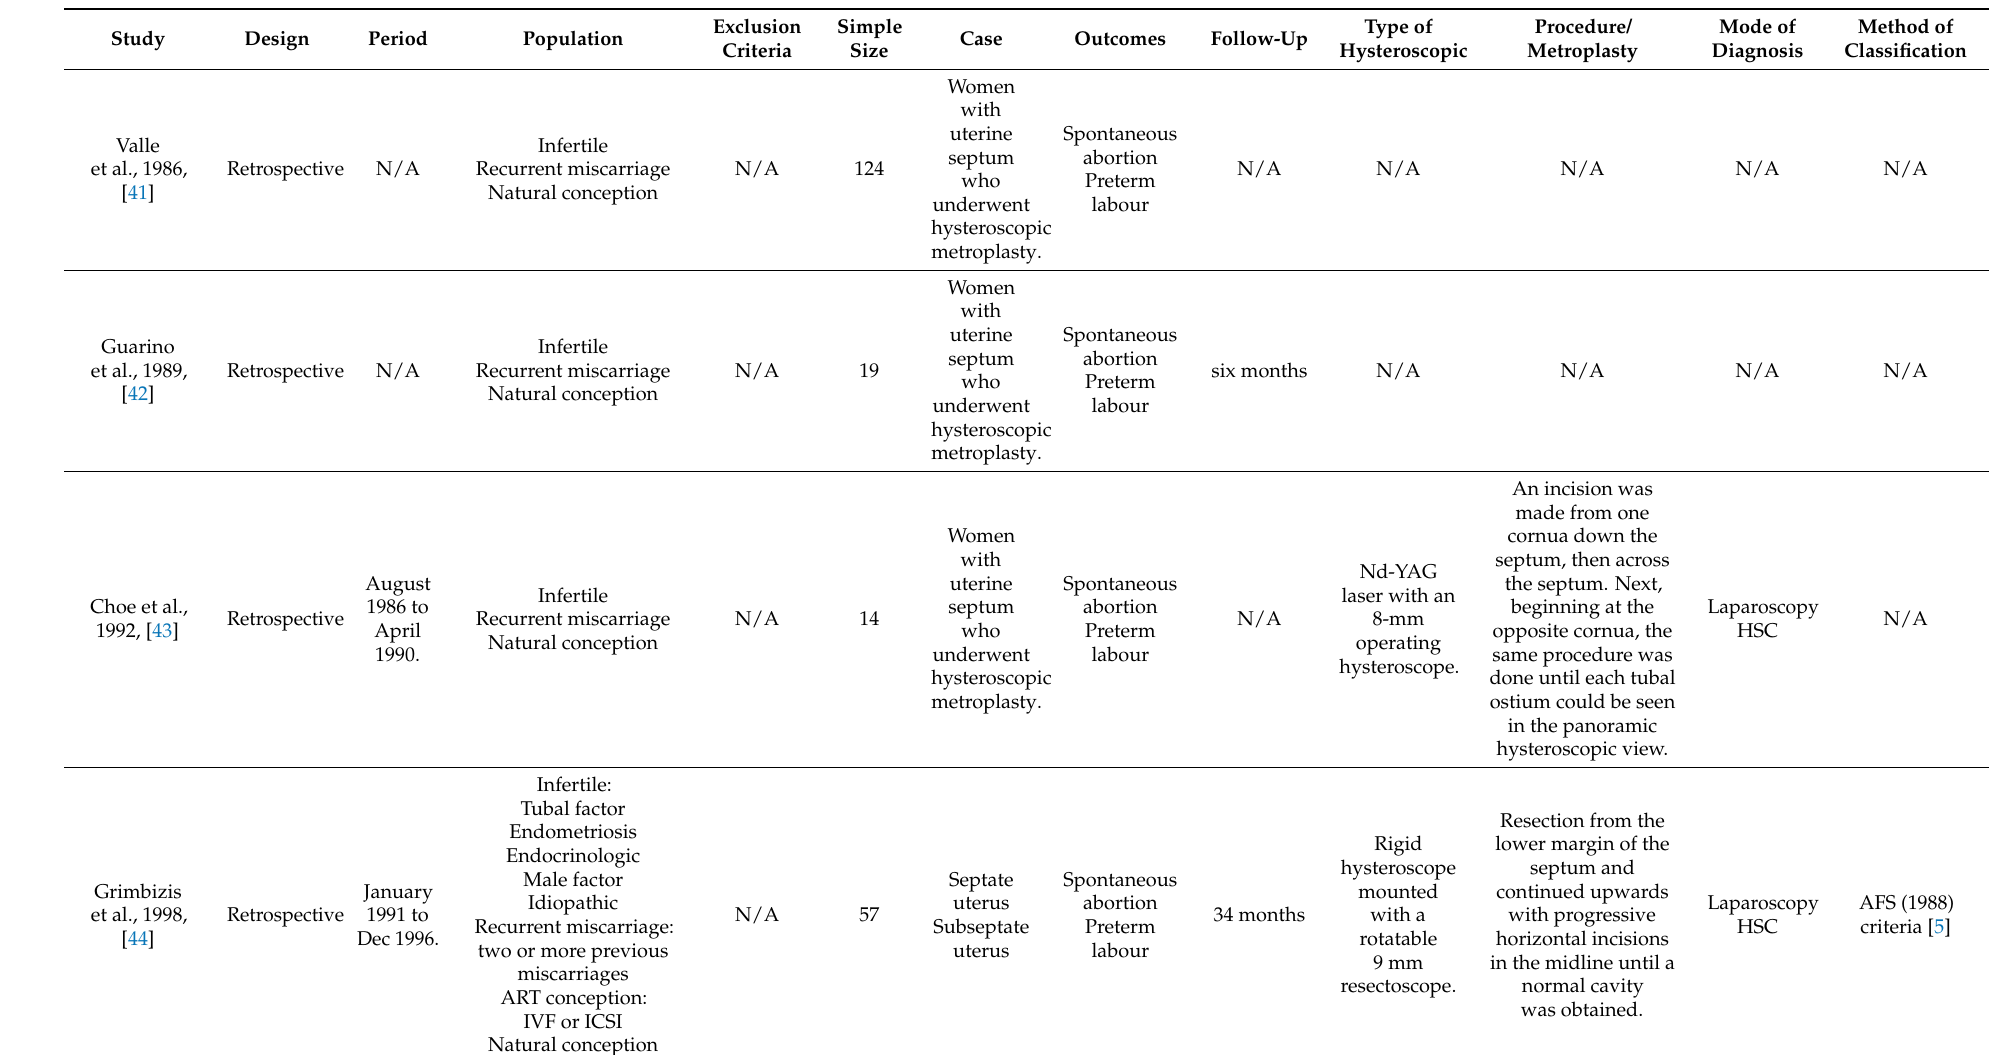
Table 3. General features of studies included in the meta-analysis: Before and after septum